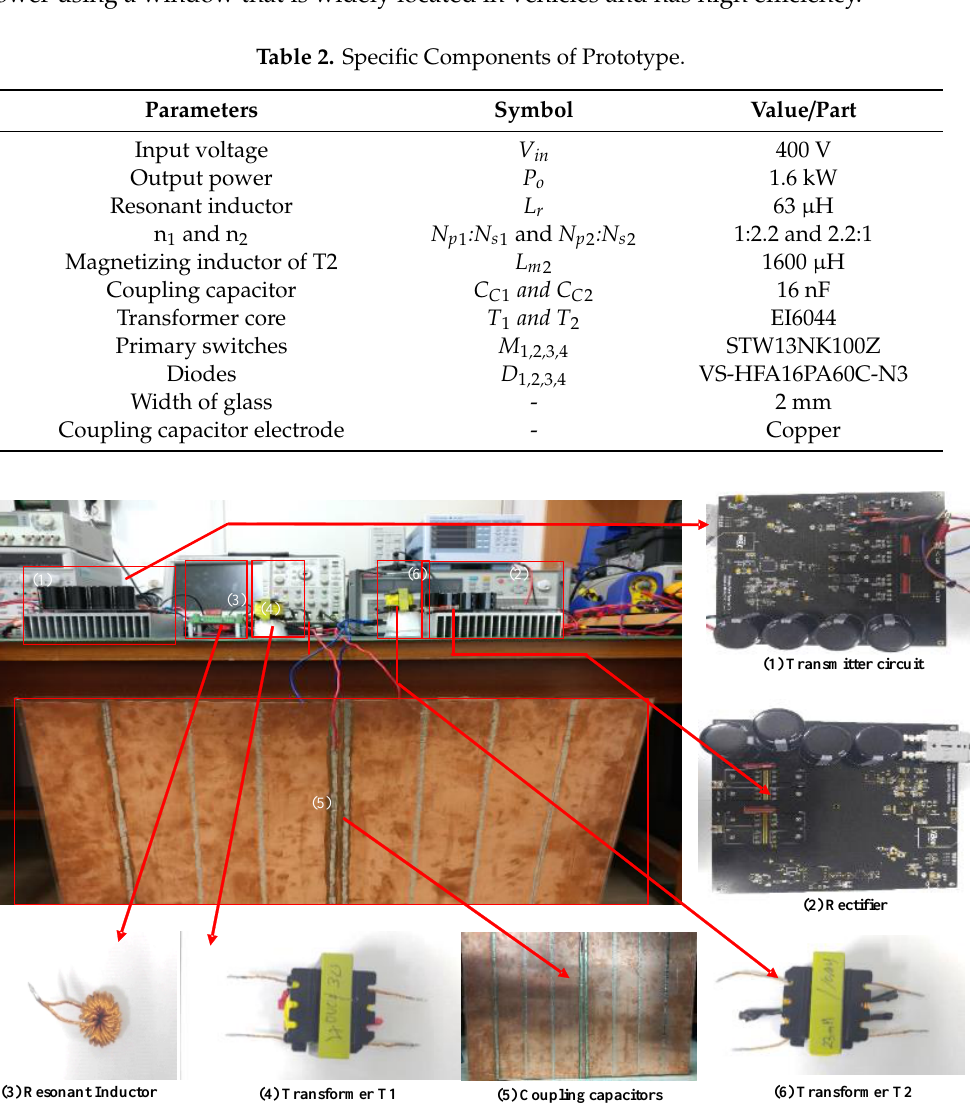
Table 2. Specific Components of Prototype.